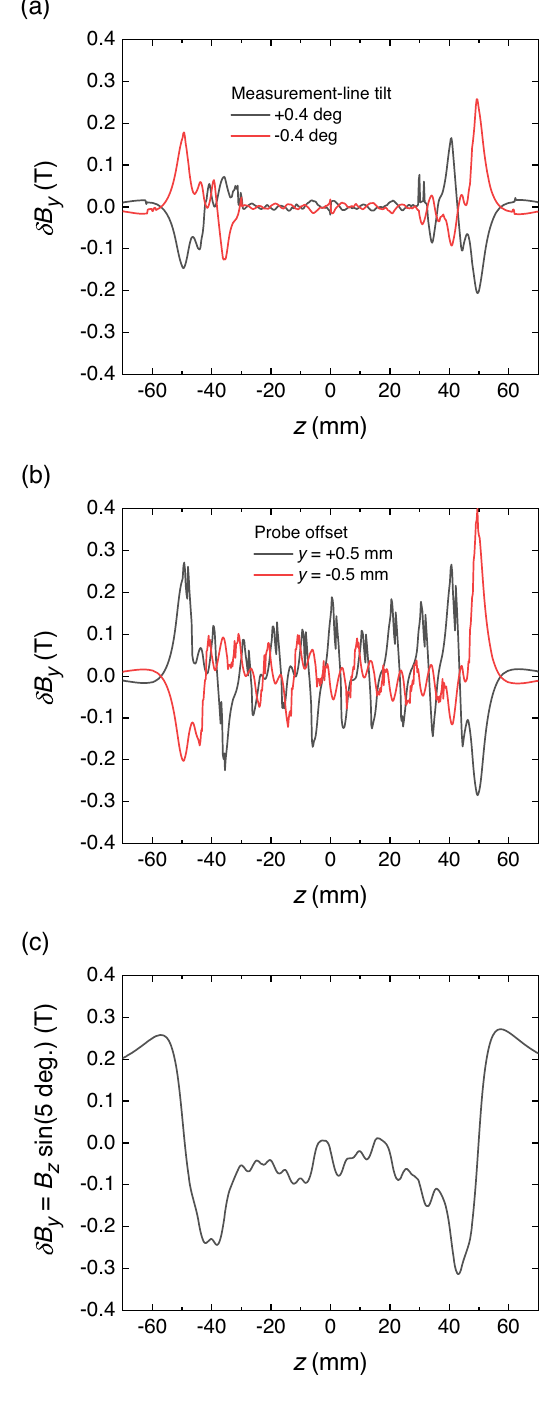
FIG. 11. Error sources for the measurement. Error due to (a) the tilt of the measurement line, (b) the probe offset in the y -direction, and (c) the contamination of B simulation was carried out with B Sec. III